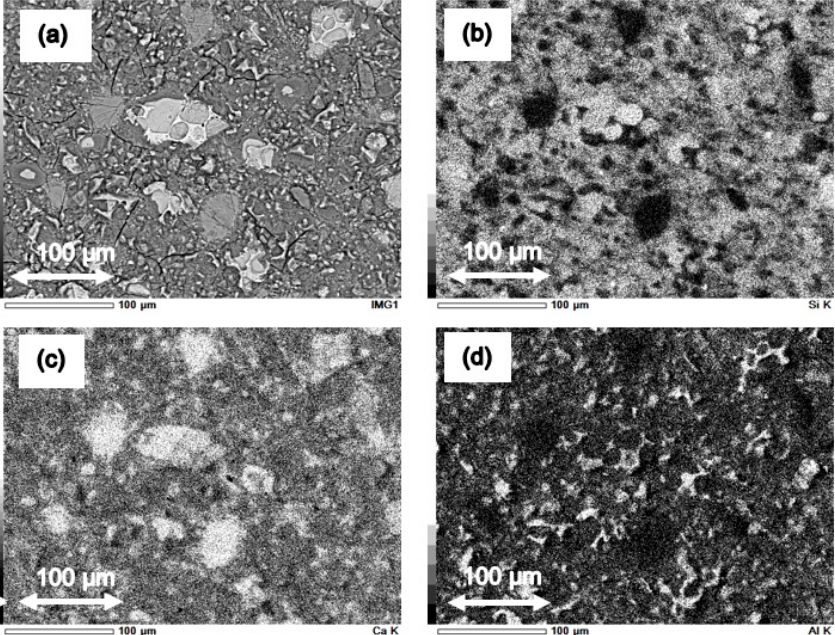
Figure 13. EDX mappings of chemical elements in the microstructure of the reference series CI_0: ( a ) area of the performed distribution, ( b ) images of Si incidence, ( c ) images of Ca incidence, ( d ) images of Al incidence.